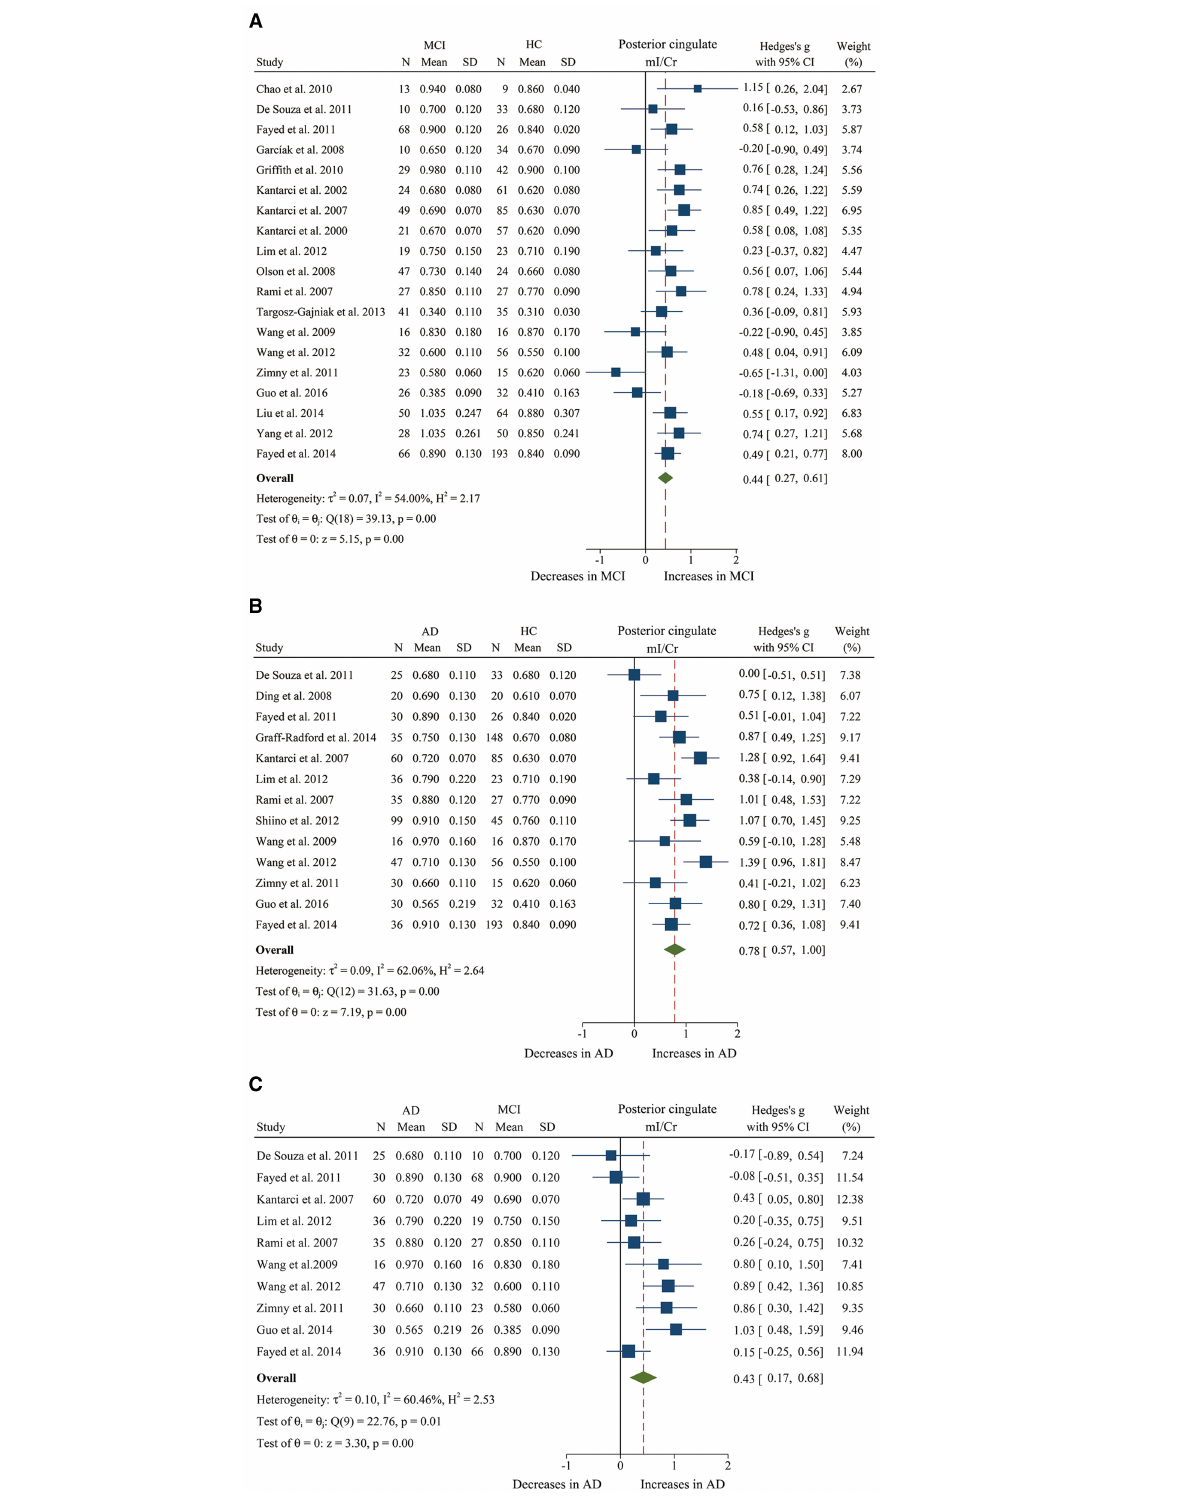
FIGURE 5 | Forest plots show the change of the ratio of mI/Cr in the posterior cingulate between MCI, AD patients, and HC subjects. (A) Data include 1481 individuals from 19 studies for meta-analysis of mI/Cr levels between MCI and HC. (B) Data include 1,218 individuals from 13 studies for meta-analysis of mI/Cr levels between AD and HC. (C) Data include 681 individuals from 5 studies for meta-analysis of mI/Cr levels between AD and MCI.